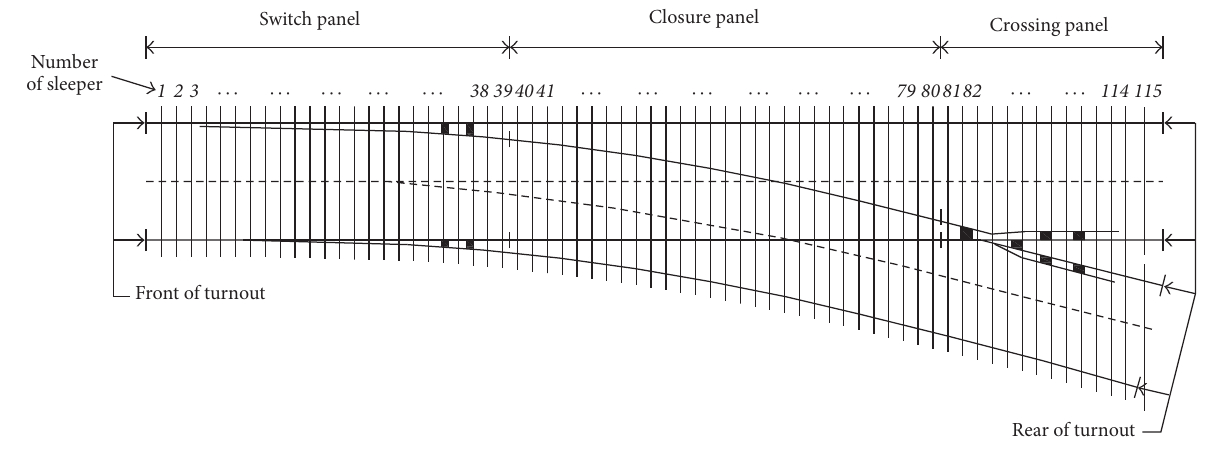
Figure 3: Sleeper arrangement of the #18 high-speed turnout in China (the sleeper pitch is 0.6 m).